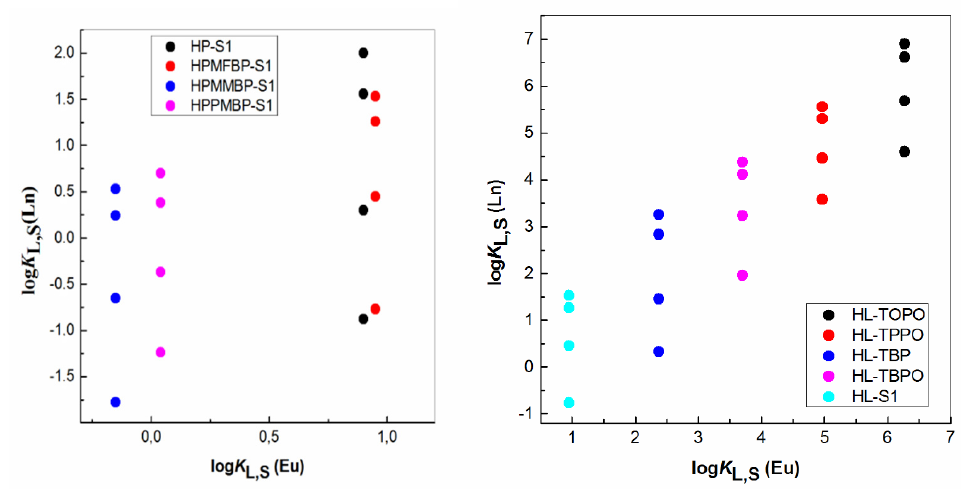
Figure 12. Comparison of log K L,S (La, Nd, Ho and Lu) vs. log K L,S (Eu) values obtained using several synergistic mixtures.